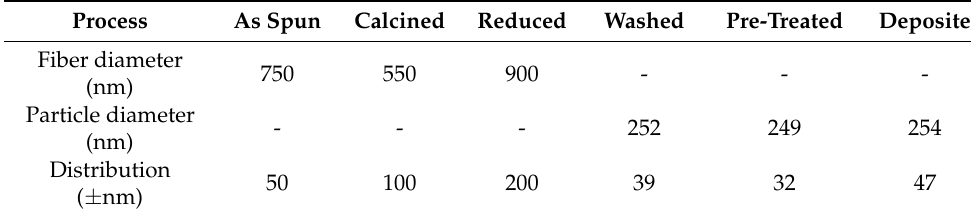
Figure 1. Micrographs of Nd 2 Fe 14 B nanoparticle fabrication process after each stage: ( a ) as spun, ( b ) calcined, ( c ) reduced and ( d ) washed. Table 1. Measured diameters of the sample at each process stage.